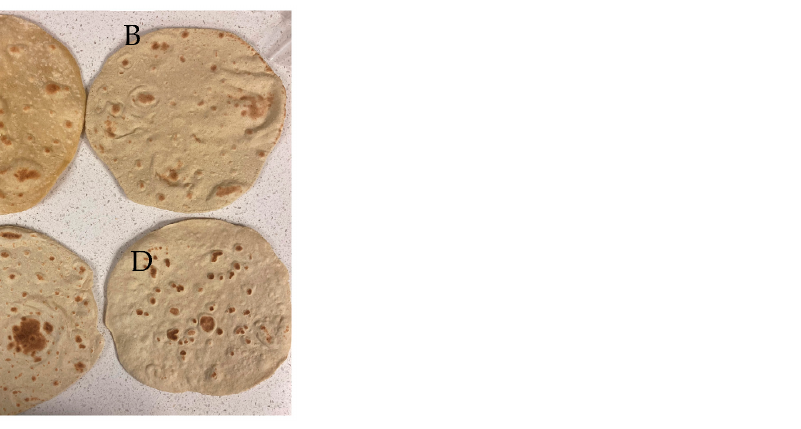
Figure 3. Roti (Indian flat bread) prepared from unfortified or fortified flour stored at room temperature for 21 days; ( A ) WF: whole wheat flour, ( B ) CM50: whole wheat flour + color-masked 17.5 mg iron roti, ( C ) EC50: whole wheat flour + encapsulated 17.5 mg iron roti and ( D ) EC100: whole wheat flour + encapsulated 35 mg iron.